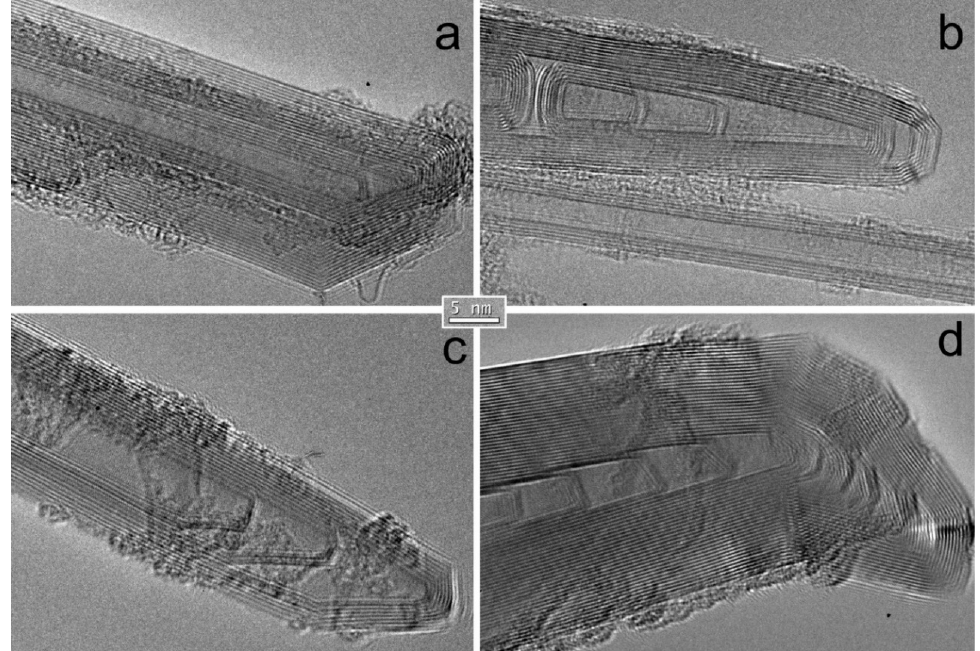
Figure 1. HRTEM images of ends of as-received, arc-prepared MWCNTs from two different com- mercial batches: ( a , b ) from MER Corporation; ( c , d ) from Sigma Aldrich.